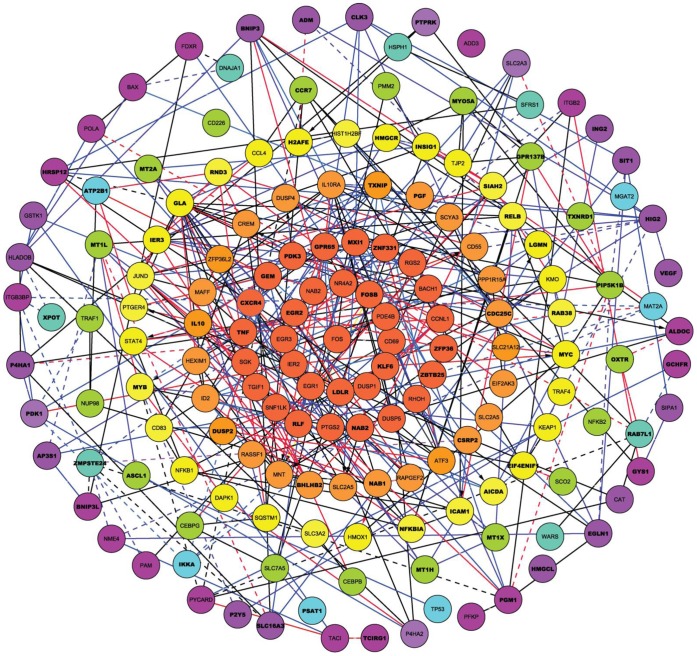
Gene network interaction after B cell stimulation of SLE patient and normal control samples.A gene network interaction map (from the initial analysis group) built using the partial correlations method is shown. Genes were grouped in different colored clusters representing maximum expression levels at various time points after B cell stimulation. The center gene clusters represent genes with maximum expression levels obtained after 0.5 hours of stimulation; then followed by colored circles for genes with maximum expression levels at 1, 2, 4, 8 hours, while the genes in peripheral circle reach maximum expression levels 16 to 24 hours after stimulation. Blue lines linking genes represent gene associations found in normal control samples. Red lines represent gene associations found in SLE patient samples. Black lines indicate gene associations found in both groups. Dashed lines represent negative gene associations.